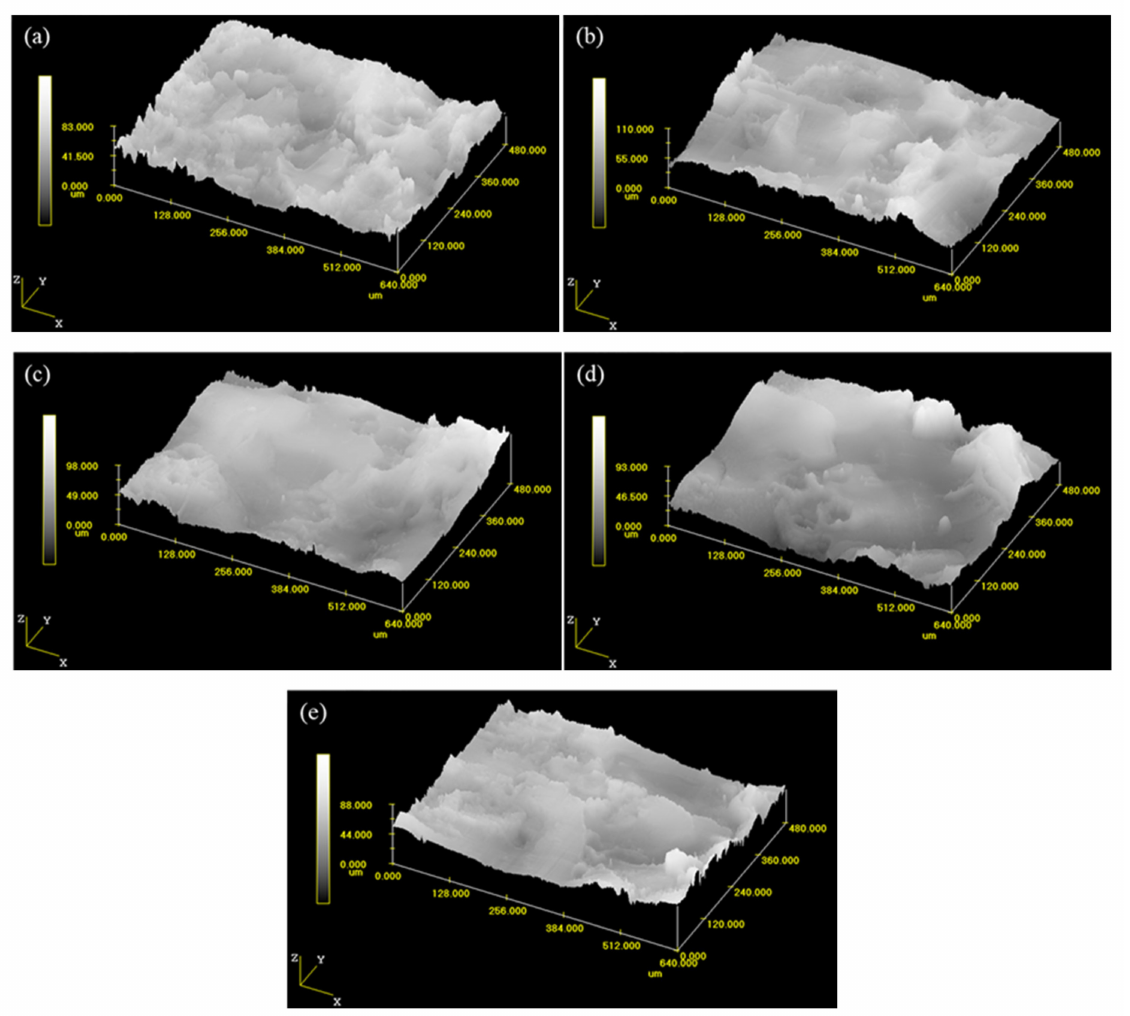
Figure 4. The three-dimensional morphology of coating deposited with different deposition power: ( a ) 100 W (Ra = 2.6 µ m),